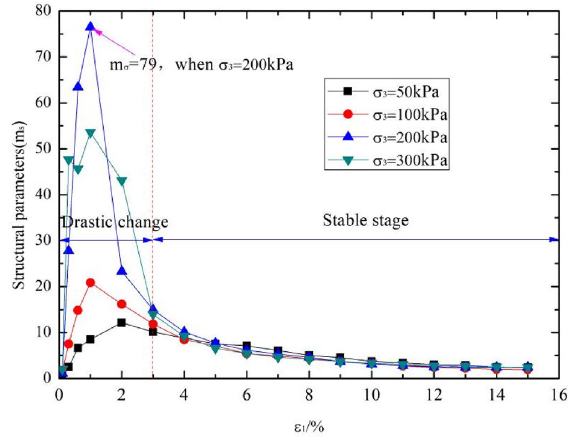
Figure 8. Variation law of structural parameters of sample 3.